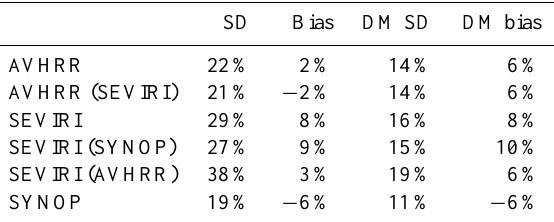
Table 6. Summary of standard deviations and bias for the compar- isons between instantaneous and daily mean CFC in Hannover, Ger- many. Results show the deviations of SEVIRI, AVHRR and SYNOP to HSI. The corresponding data set has been matched to the data set in parentheses. A lack of parentheses indicates that the data set has only been matched to